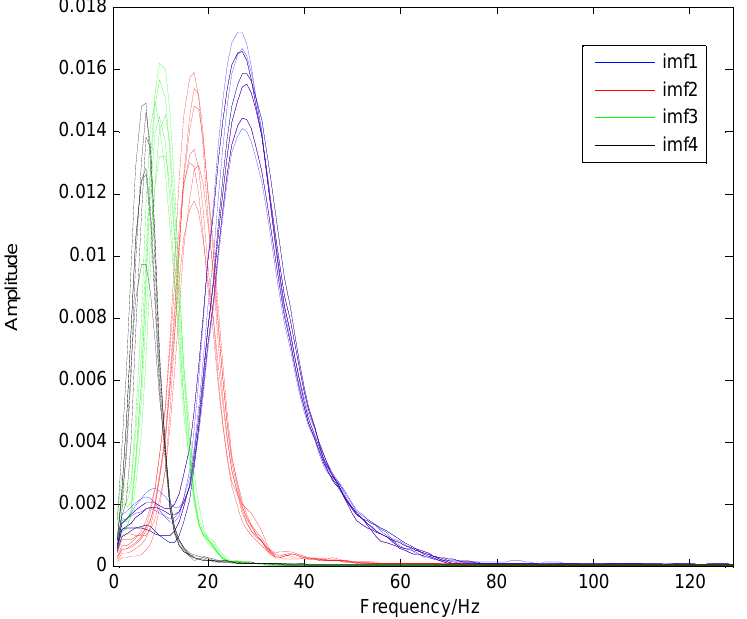
Figure 15. Power spectra of MIMFs from different sessions of record 302 m.